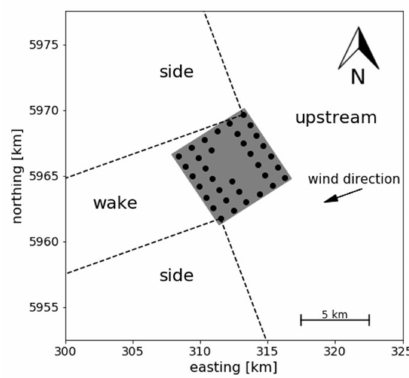
Figure 4. Regions for an example SAR image from 27-04-2018. Three regions “side”, “wake”, and “upstream” are indicated (dashed lines) along with the wind direction (north-easterly for this example). The turbulence intensity ( TI ) is traditionally measured from a time series at a single location. For Doppler radar wind measurements this is not convenient as the temporal sampling frequency is low. One alternative is using TI derived from the instantaneous wind field itself. [32] suggested a method